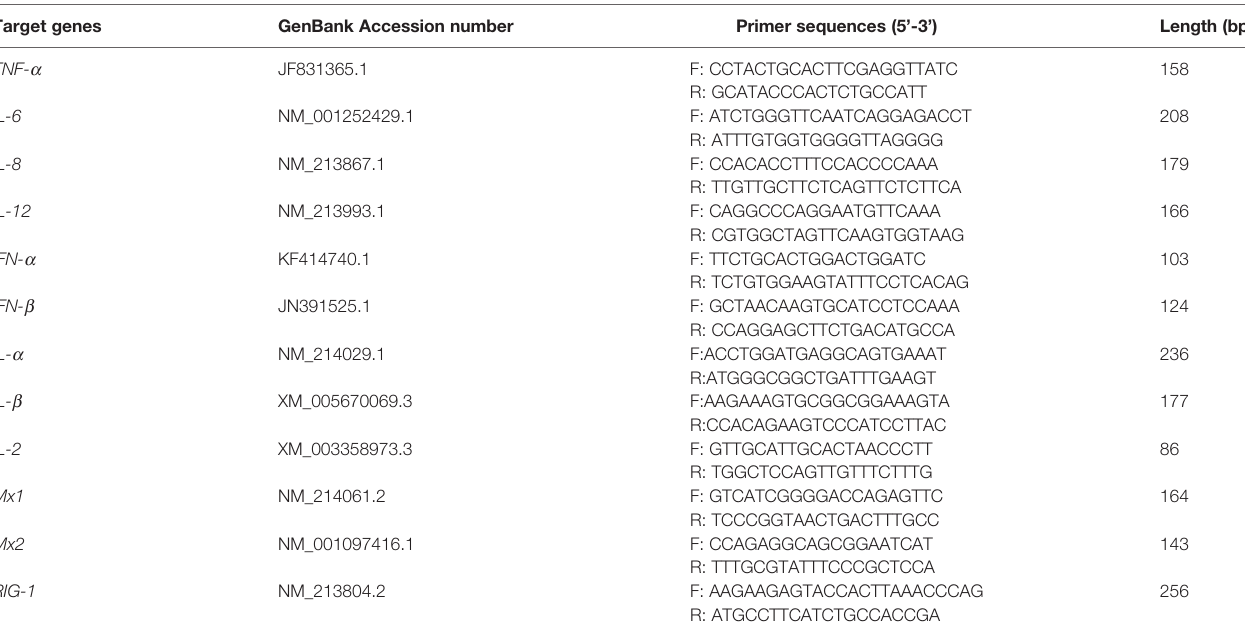
TABLE 3 | Primers of in fl ammatory cytokines and antiviral